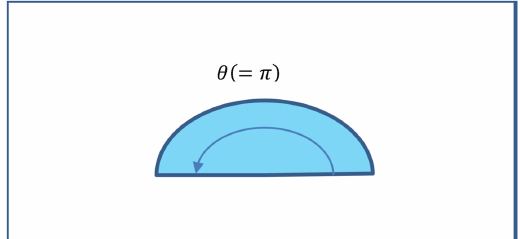
Figure 3. Shadow of a